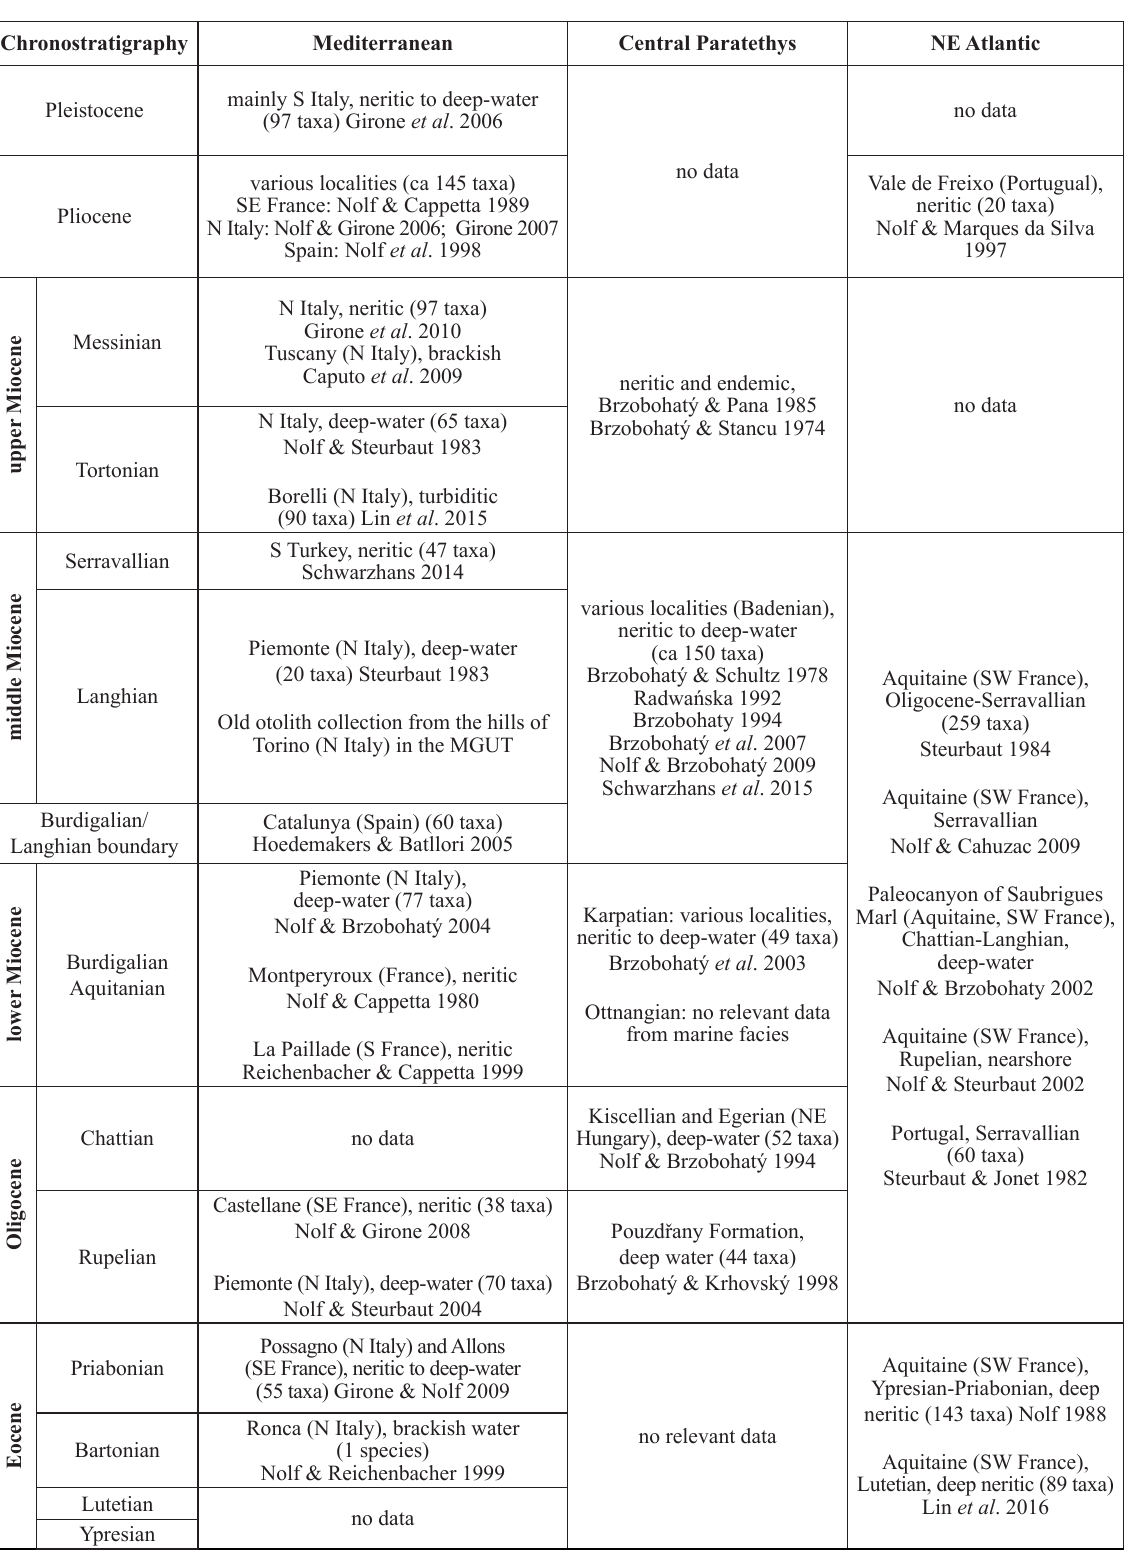
Table 3. Important otolith assemblages and studies from the Eocene to Pleistocene in the Mediterranean Area, the Central Paratethys and the NE